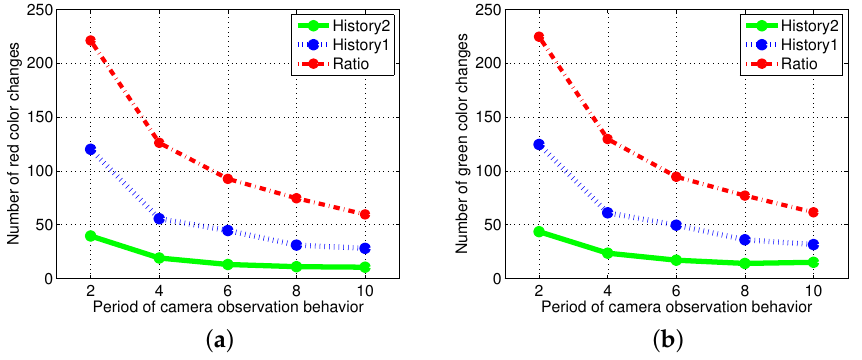
Figure 11. Comparison of the results of the number of task changes with a variation in the vision sampling period from two to ten time steps. ( a ) Task changes for red pucks; ( b ) task changes for green